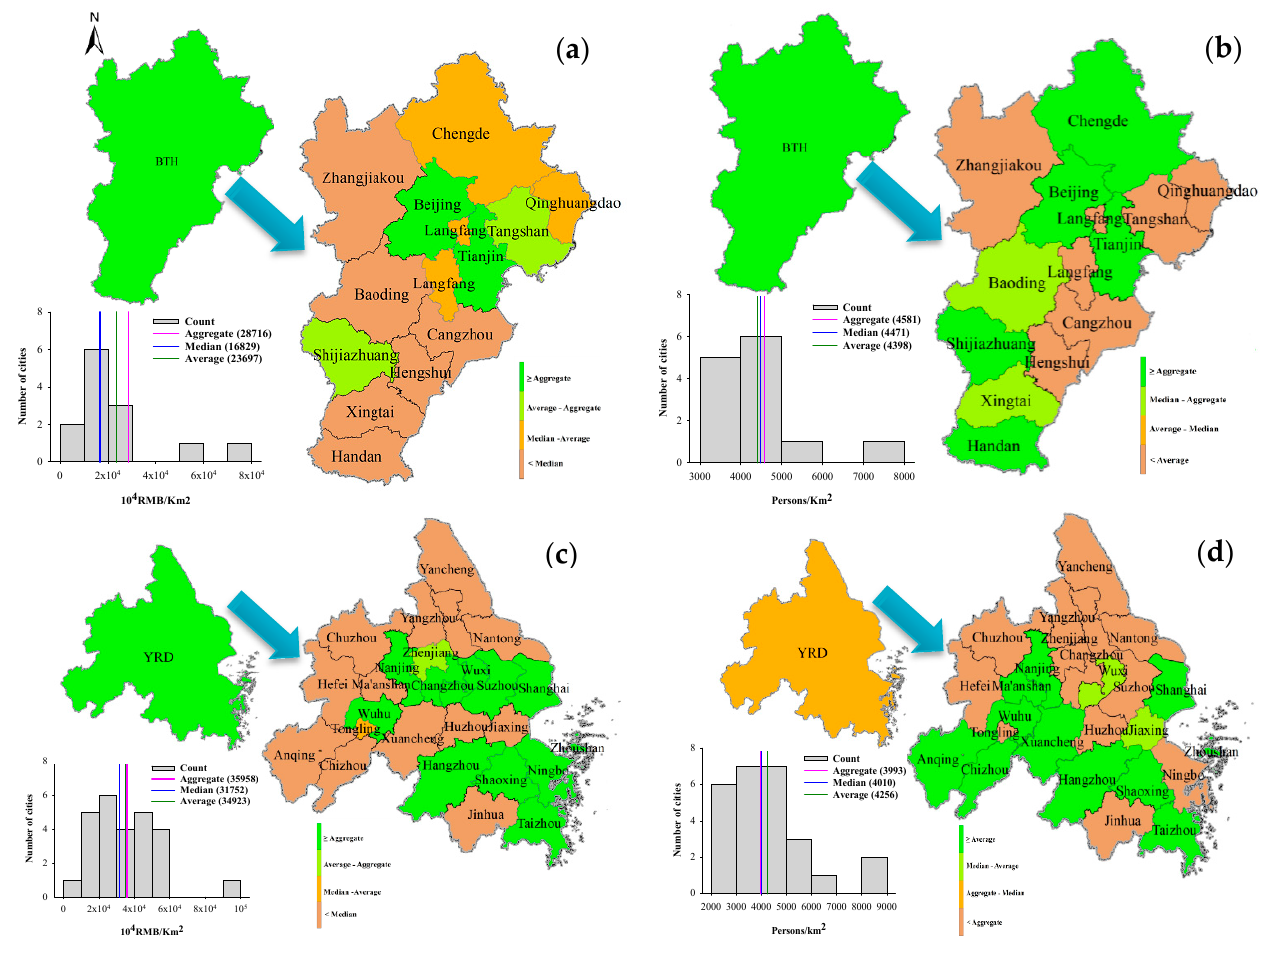
Figure 5. Comparisons of ULUE values according to different metrics. GDP output per unit of construction land in the BTH urban agglomeration ( a ), population density per unit of construction land in the BTH urban agglomeration ( b ), GDP output per unit of construction land in the YRD urban agglomeration ( c ), and population density per unit of construction land in the YRD urban agglomeration ( d ).